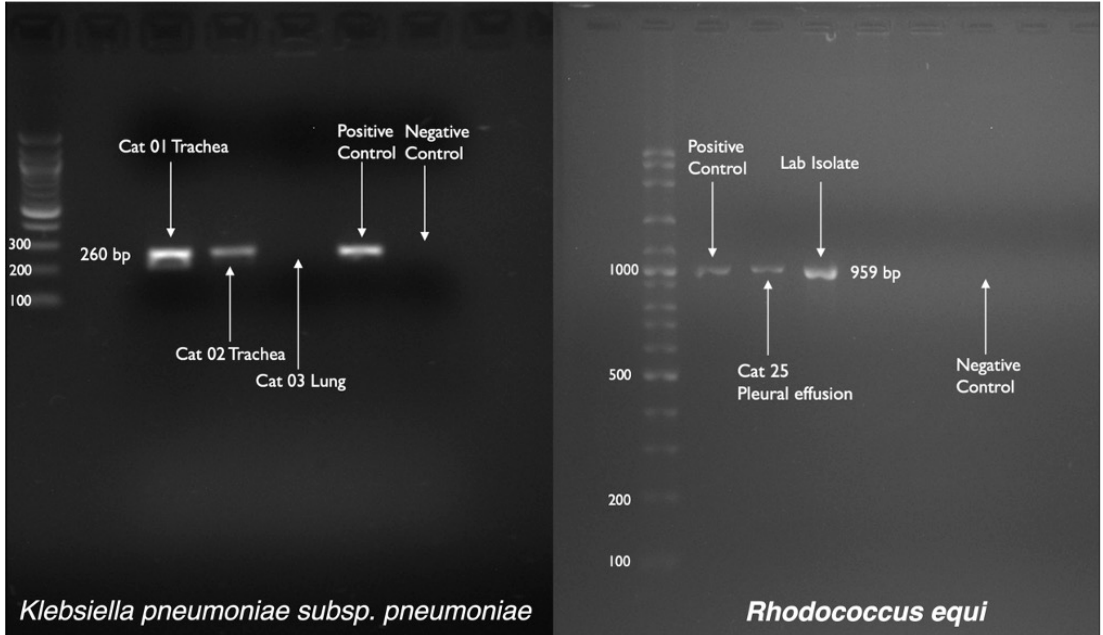
tory disease signs.